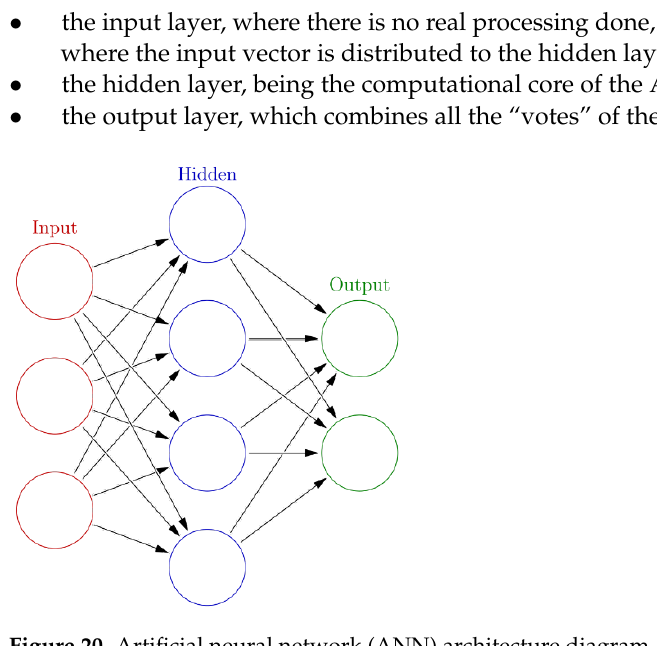
Figure 20. Artificial neural network (ANN) architecture diagram.